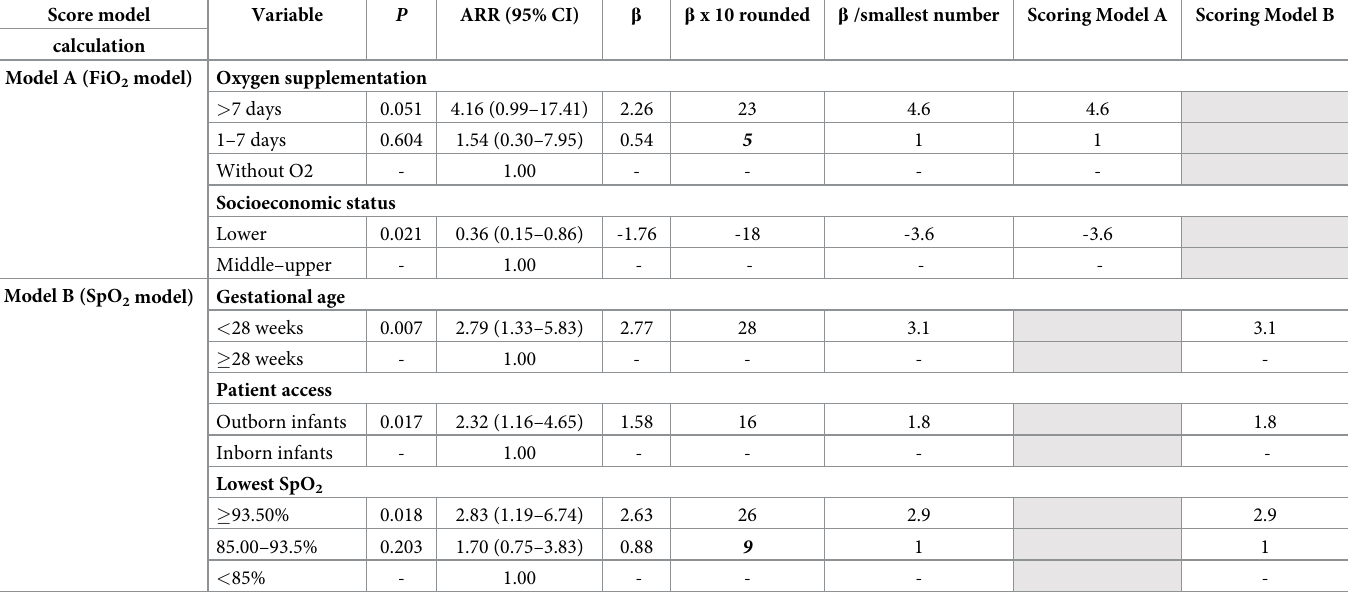
Table 1. Modified calculation of scores for the establishment of an ROP risk